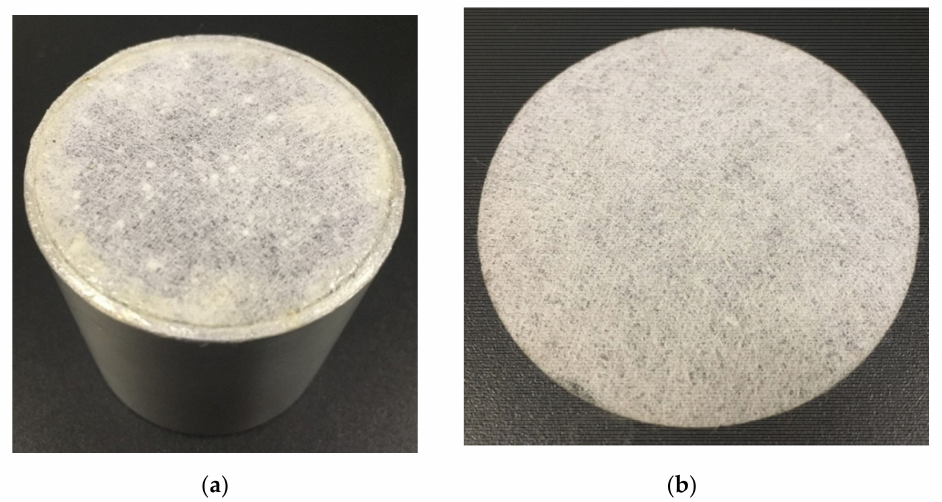
Figure 7. Examples of protective layers: ( a ) top surface of the sample closed by the protective layer sealed by glue; and ( b ) protective